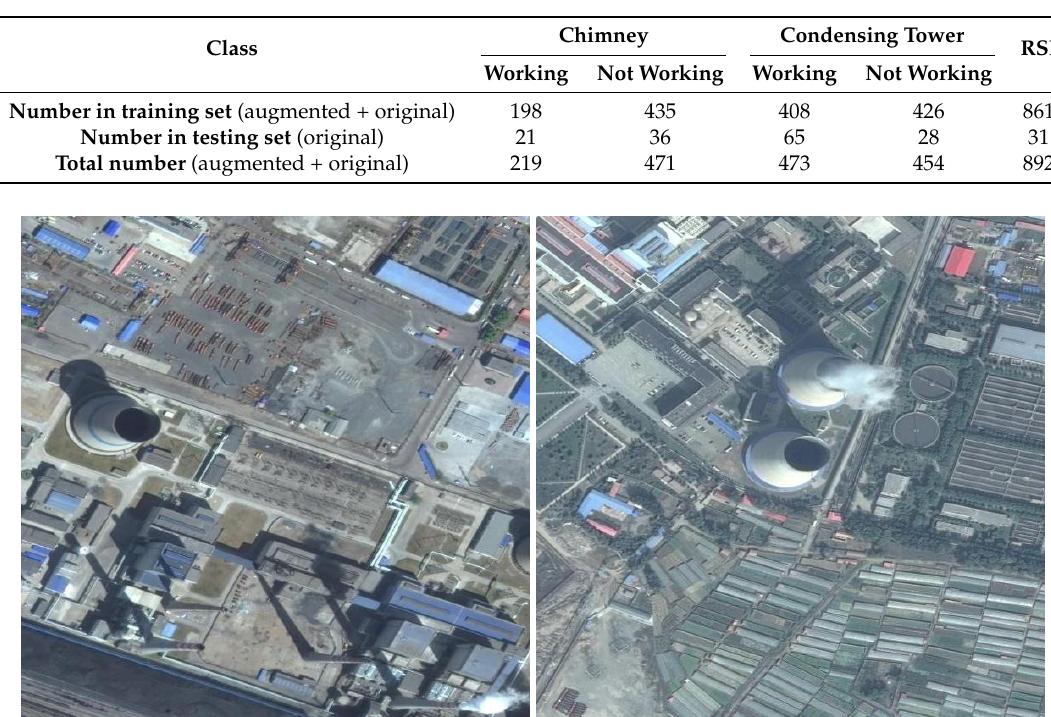
Table 3. Statistics of BUAA-FFPP60